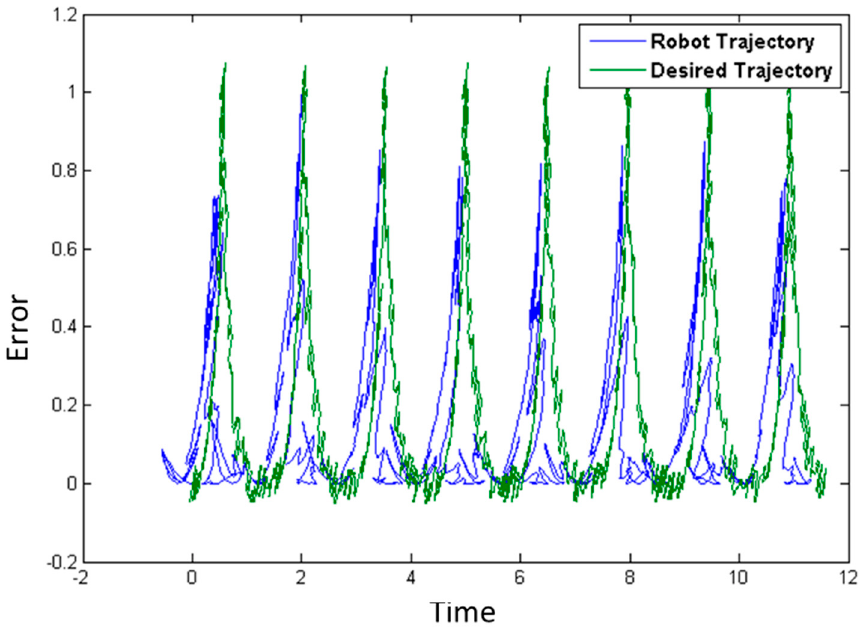
Figure 16. Best trajectory for FGSO1T2 with noise.